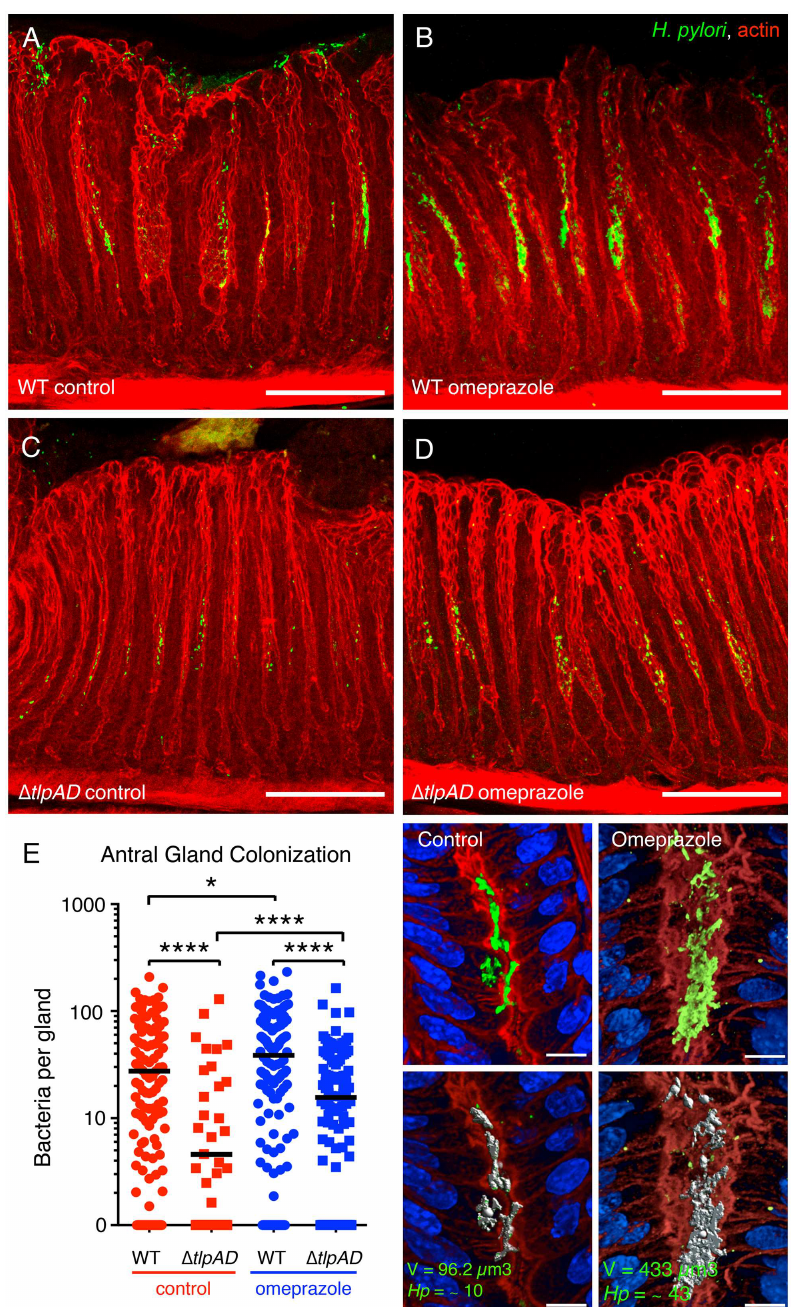
Fig 7. The density of gland-associated H . pylori in the antrum of the stomach is influenced by gastric acidity. ( A-D ) 3D confocalimmunofluorescencereconstructions of mice infected with wild-type(WT) or Δ tlpAD H . pylori followedby treatment with omeprazole or no treatment. H . pylori are stained in green and actin in red. Scale bar is 100 μ mfor all 4 panels. ( E ) Quantificationof the number of bacteriaper gland in the antrum of animalsinfected with WT or Δ tlpAD treated with omeprazole or untreated. The antral glandsof seven animalsin each cohort were analyzedfor bacterialcolonization by 3D volumetricanalysis.The number of bacteriain each individual glandis plotted as a scatter point. * P < 0.05, **** P < 0.0001(Mann Whitney test). The panelson the right show an exampleof the volumetricmeasurement of bacteria in gastric glands. 3D confocalreconstructions of glandsstainedwith anti– Hpylori ( green ),phalloidin( red ), and DAPI ( blue ) were generated.Bacterial microcolony signals are identified by fluorescence intensity and size using Volocity software and the identifiedvoxels marked in gray ( bottom panels )are measured. The numberof bacteria per gland is calculatedbasedon the averagevoxel volume of 1 bacterium. Scale bar is 10 μ m for all 4